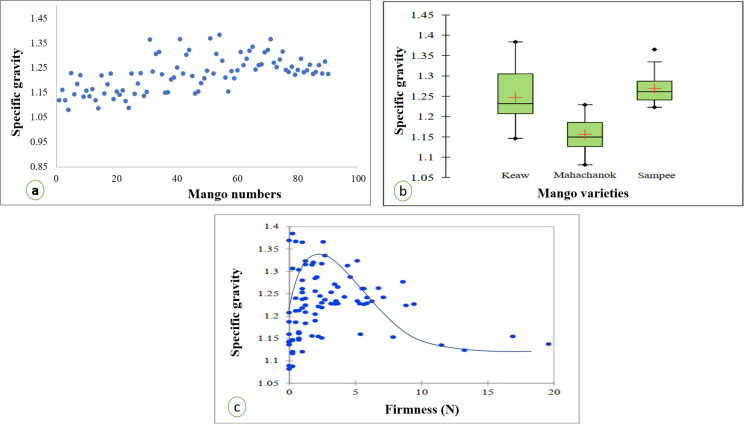
Determination of the ripening stage of Thai mango fruits by specific gravity (a) and Box plots diagram of specific gravity of different mango varieties (b) and two decay relationship of specific gravity and fruit firmness (c).